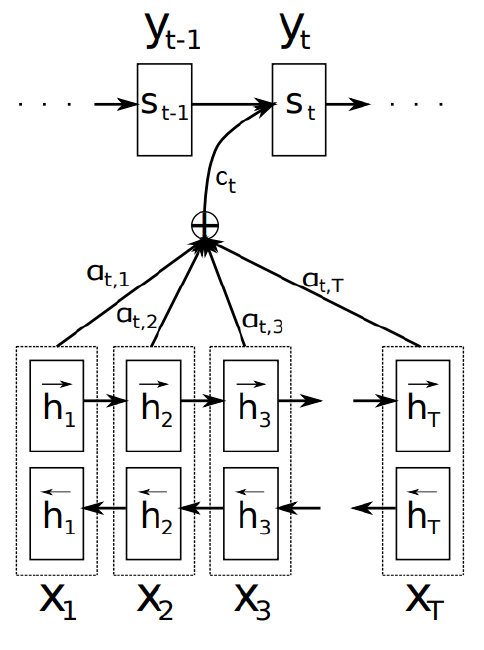
Figure 1. Original graphical representation of the attention model by Bahdanau et al. in